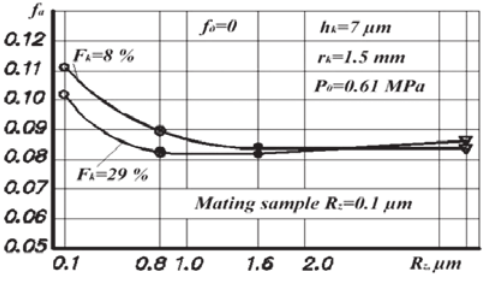
Fig. 6. Dependence of the adhesion component of the friction factor f а on the relative area of micro grooves F к at a depth of micro grooves h к : h К1 = 20 µm; h К2 = 11 µm; h К3 = 7 µm;